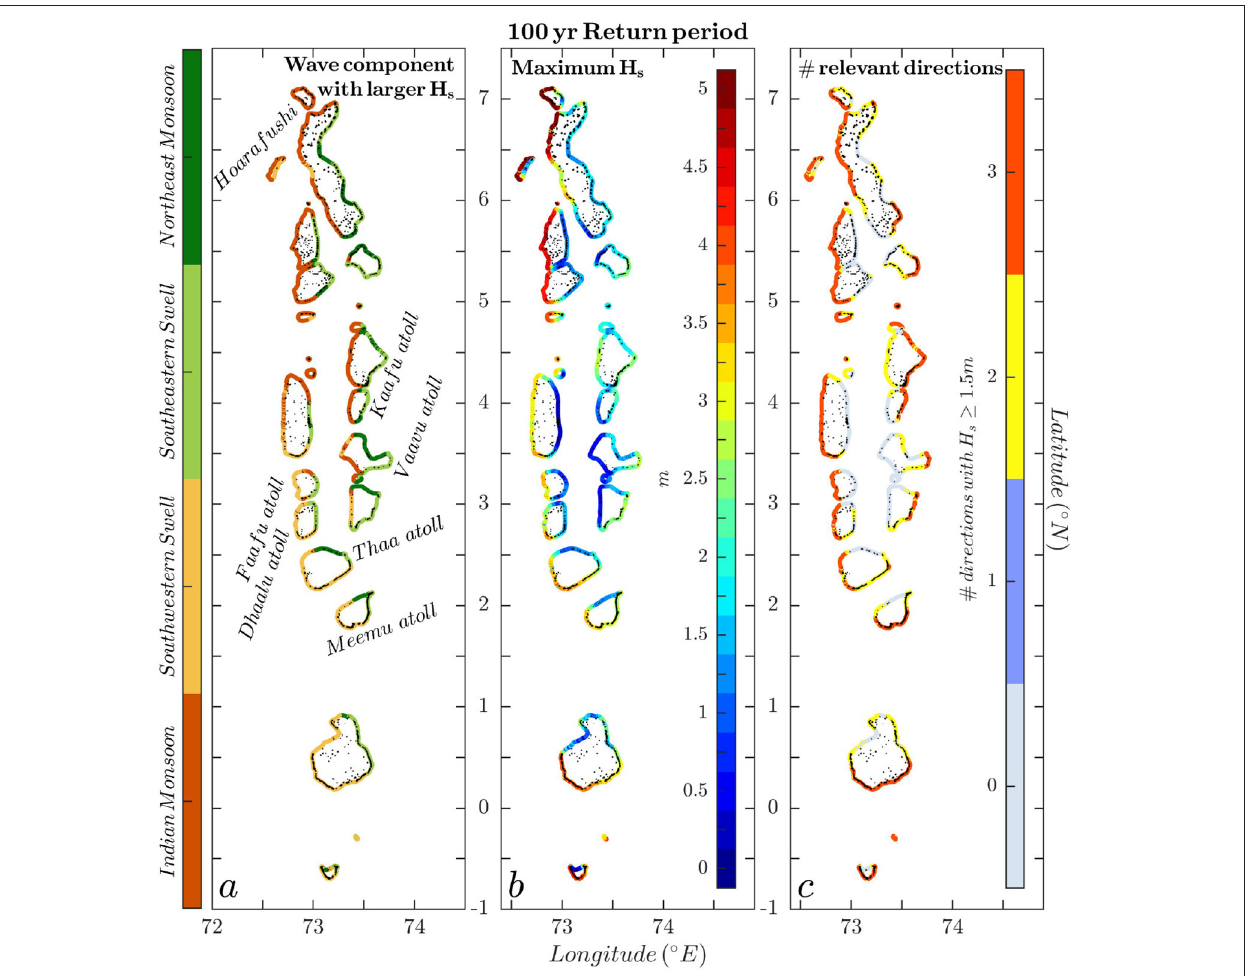
FIGURE 7 | Products derived by combining the regional downscaling for the 100 year return period of the 4 wave components in Figure 6 along the Maldivian coastlines. (a) shows the wave component causing the largest H s at each coastal point; (b) the maximum H s at the coast; and (c) , the number of wave directions with H s larger than 1.5 m that hit each coastal location for the 100 year return